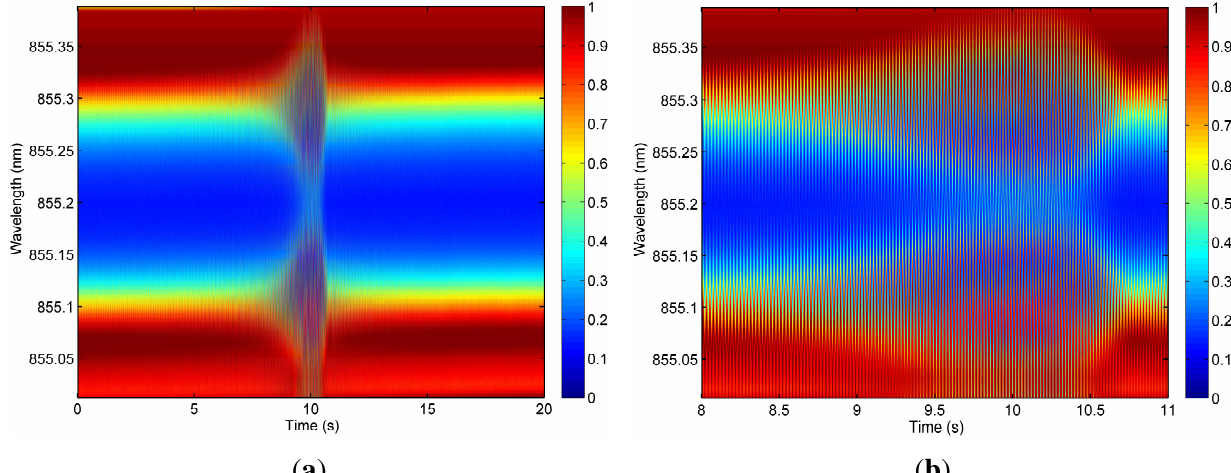
Figure 16. Electrodynamic shaker characterization of the fully embedded system (relative wavelength intensities). ( a ) Full spectral reconstruction of the resonance effect; ( b ) Zoomed view of the full spectral